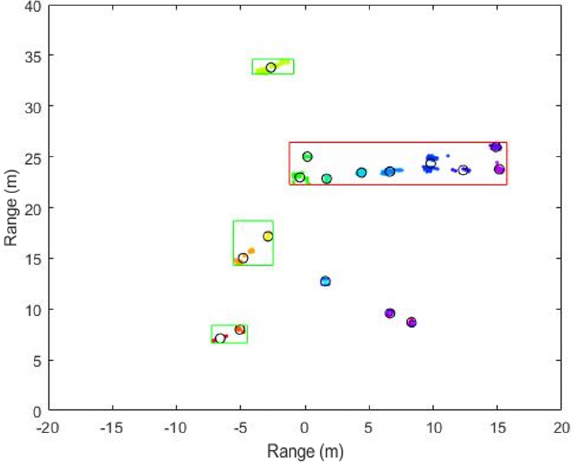
Figure 8. Example of detection performance of the conventional and our proposed methods.